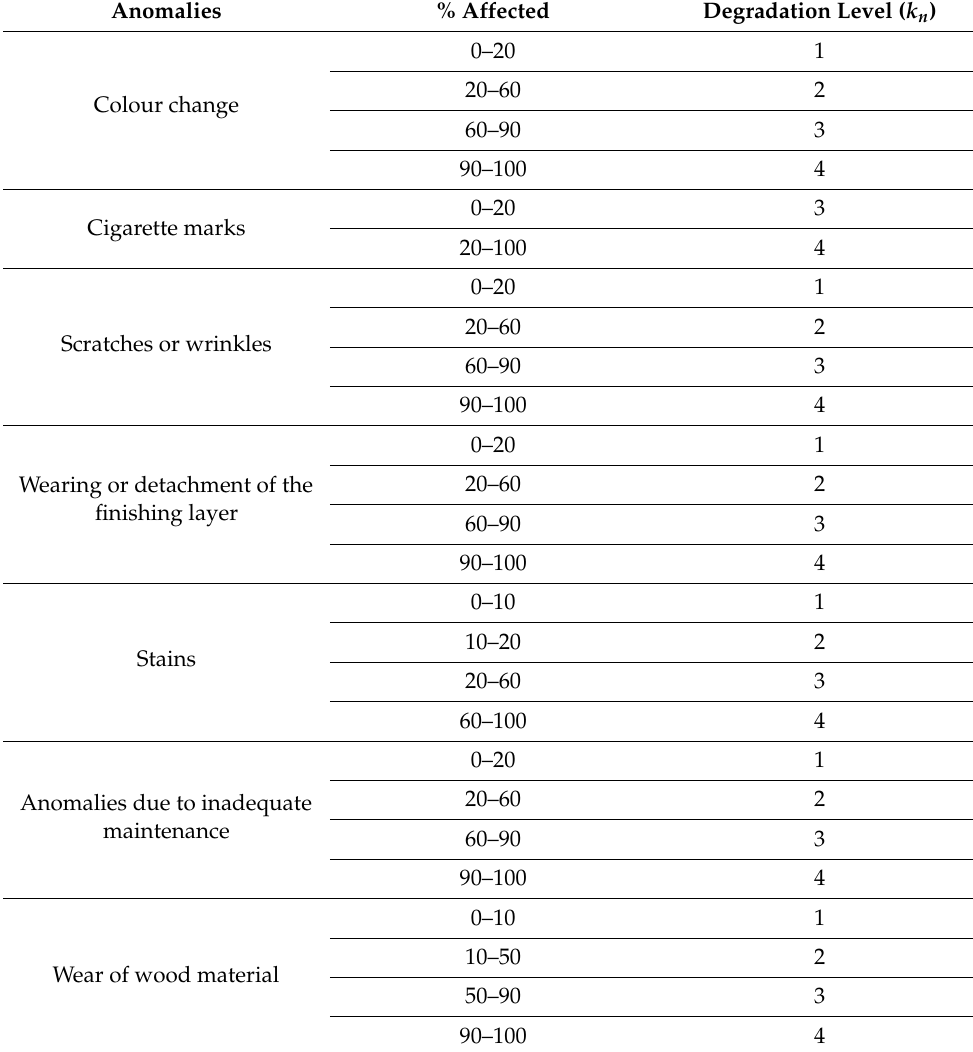
Table 1. Degradation levels of aesthetic anomalies.